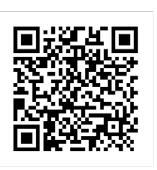
Figure 3. QR code linking to WMYC Koorie Art Class